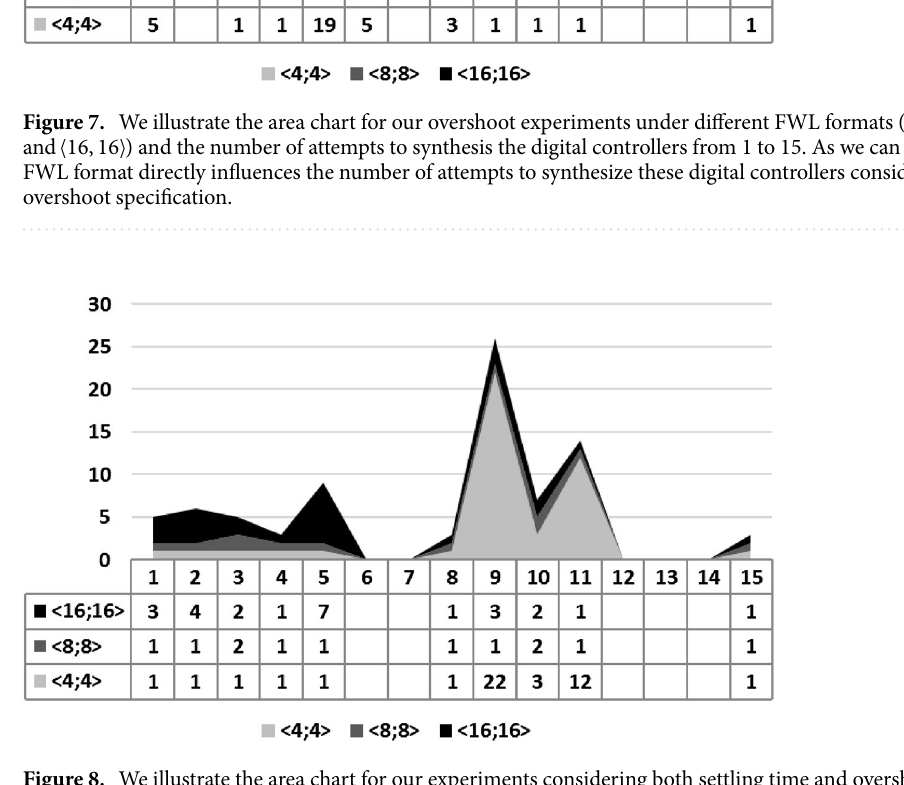
number of attempts for a smaller amount of bits. We did not find any plausible explanation for that behavior during the experiments. When experiments considering both requirements (settling time and overshoot) were performed, in FWL format (cid:31) 4, 4 (cid:30) , they took between one and twenty-two attempts, with benchmarks 1–5, 8–11, and 15. It is interest- ing to mention that benchmarks 9 to 11 have 3 eigenvalues in common ( − 0.2 , − 0.3 and − 0.7 ), and the reason for more attempts to synthesize those lies in the combination of those eigenvalues, when dealt with by GA Engine . When format (cid:31) 8, 8 (cid:30) was used, one or two attempts were necessary to successfully synthesize benchmarks 1–5, 8–11, and 15. Specifically, only benchmarks 3 and 10, both of 4th order, needed more than one attempt to be successfully synthesized. In format (cid:31) 16, 16 (cid:30) , experiments took from one to seven attempts, with benchmarks 1–5, 8–11, and 15. The majority of those experiments needed more than one attempt to be successfully synthesized. In experiments with formats (cid:31) 4, 4 (cid:30) , (cid:31) 8, 8 (cid:30) , and (cid:31) 16, 16 (cid:30) , ATT AVG figures of 4.4, 1.2, and 2.5 attempts were obtained. Although there seems to be no trend, a simple analysis regarding attempts for single requirements reveals what happened: for format (cid:31) 4, 4 (cid:30) , overshoot led to a high number of average attempts, which also hap- pened to format (cid:31) 16, 16 (cid:30) , but now due to settling time. Finally, format (cid:31) 8, 8 (cid:30) presented an intermediate number of average attempts, which is true for single requirements.